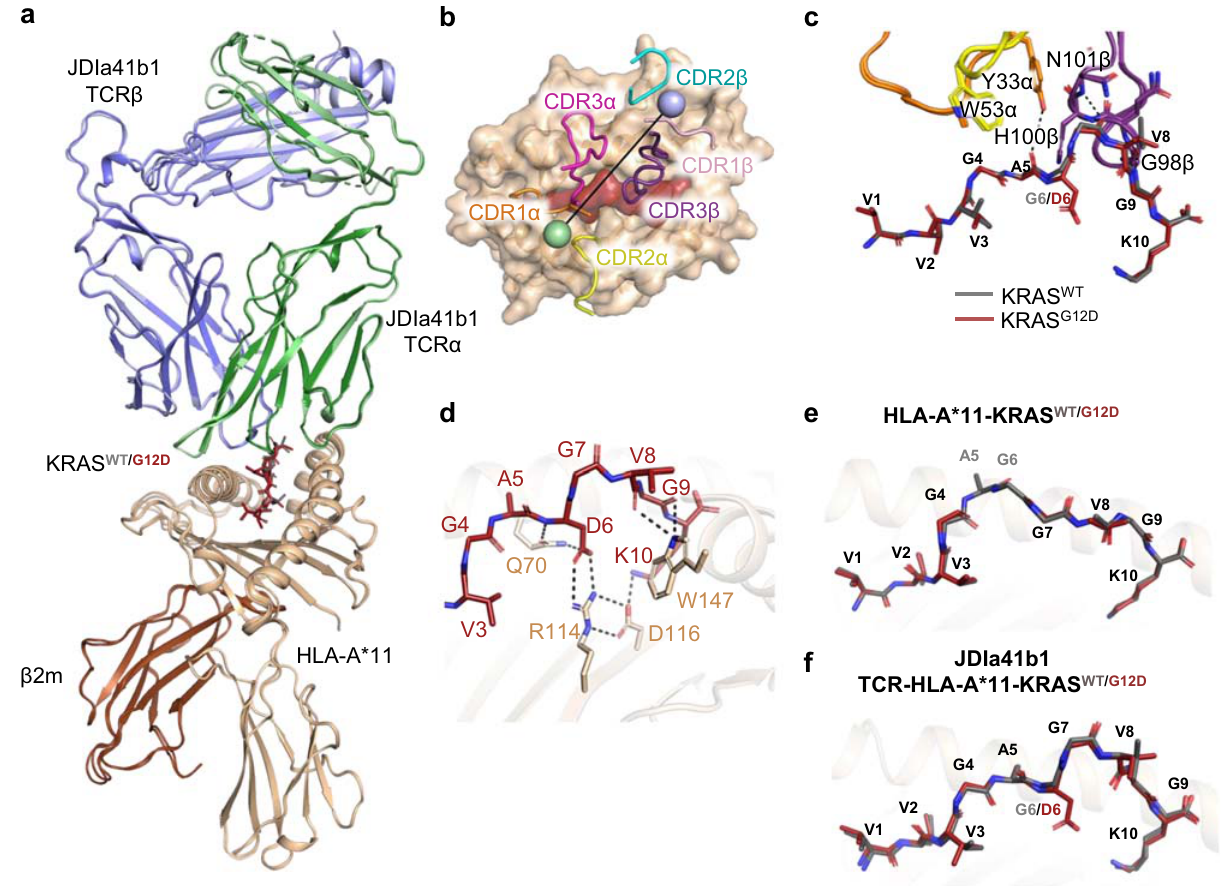
Fig. 2 | TheJDIa41b1 TCRadopts avirtuallyidenticalbinding modeincomplex with HLA-A*11-KRAS G12D and HLA-A*11-KRAS WT . a Superposition of JDIa41b1-HLA- A*11-KRAS WT (PBD 7OW5) and JDIa41b1-HLA-A*11-KRAS G12D (PBD 7OW6) complexes. The HLA, β 2m, JDIa41b1 TCR α , and TCR β are coloured in wheat,brown, green,and blue respectively. The darker shades of green and blue correspond to the JDIa41b1 TCRintheJDIa41b1-HLA-A*11-KRAS G12D complex.TheKRAS WT andKRAS G12D peptides arecolouredingreyandmaroonrespectively. b TopviewoftheJDIa41b1-HLA-A*11- KRAS G12D complex(PBD7OW6).TheHLAandKRAS G12D peptideareshowninsurface representation and the CDRs are shown in cartoon tube representations. The